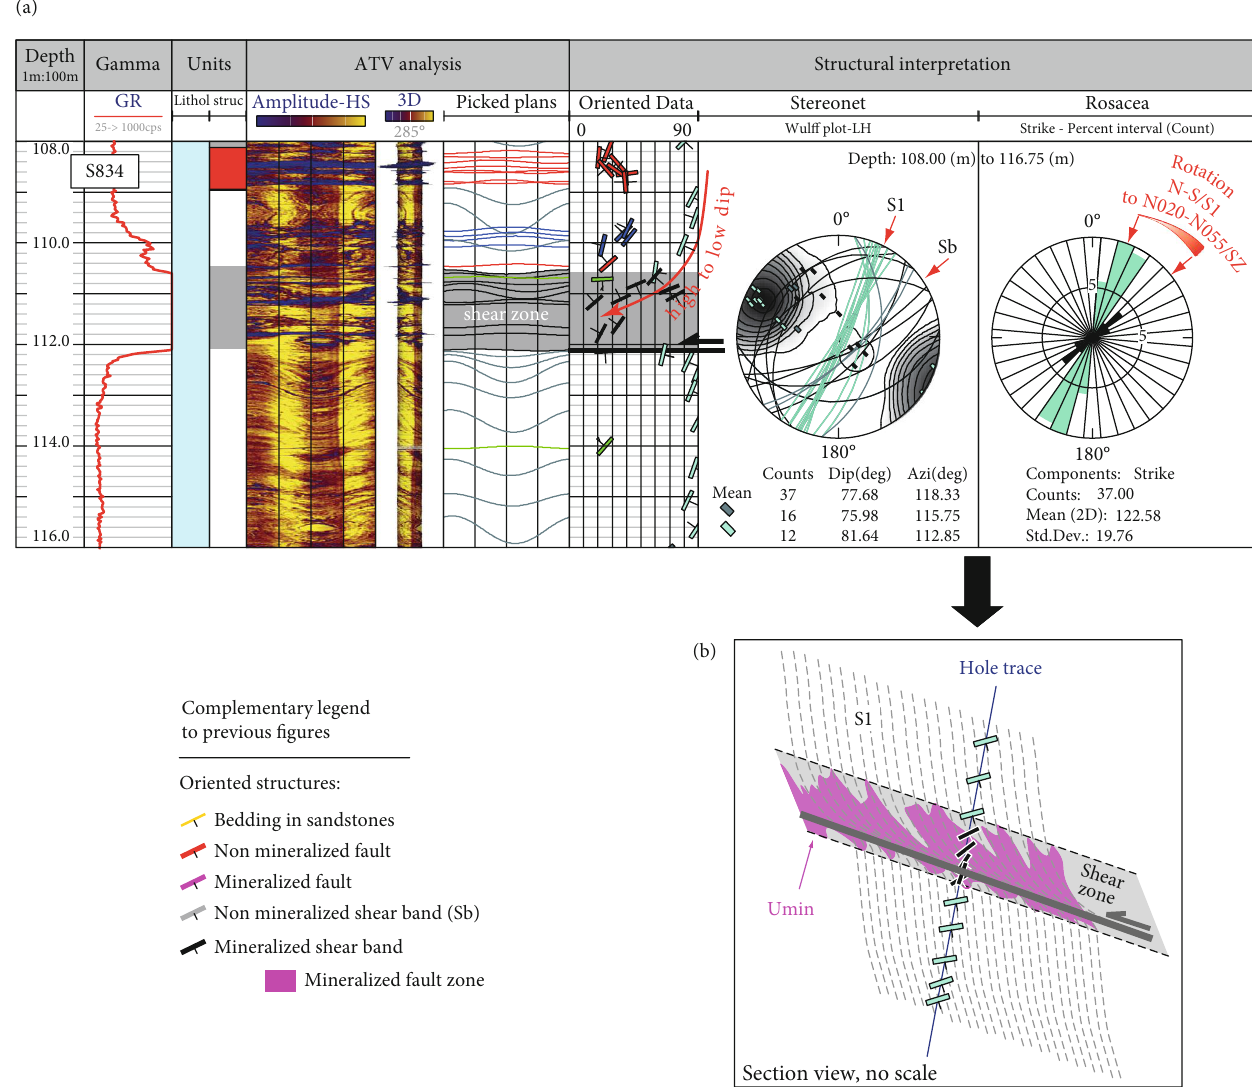
Figure 5: ATV structural analysis of drill hole S834. Disseminated mineralization occurs in a nongraphitic shear zone when it turns from NNE to NE and when dips decrease from highly steeply dipping to low angle dipping. The red arrow indicates the progressive decreasing in dip and the azimuth reorientation. Legend in Figure